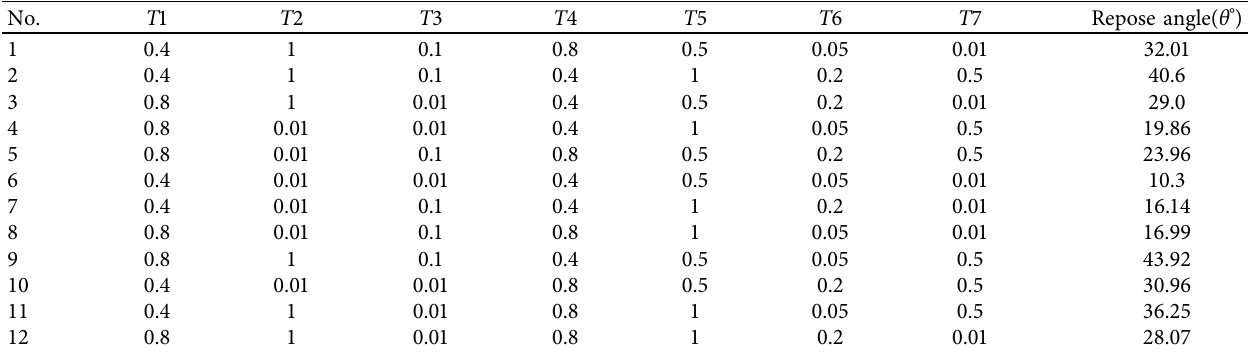
Table 2: The results of Plackett–Burman